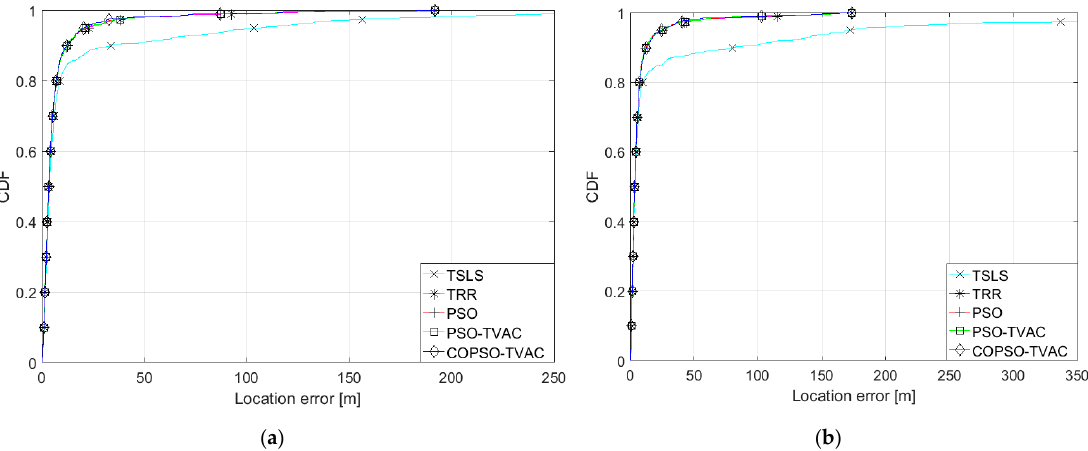
Figure 5. CDF of the location error in the scenario with 2 NLOS BSs: ( a ) the suburban environment; ( b ) the urban environment.